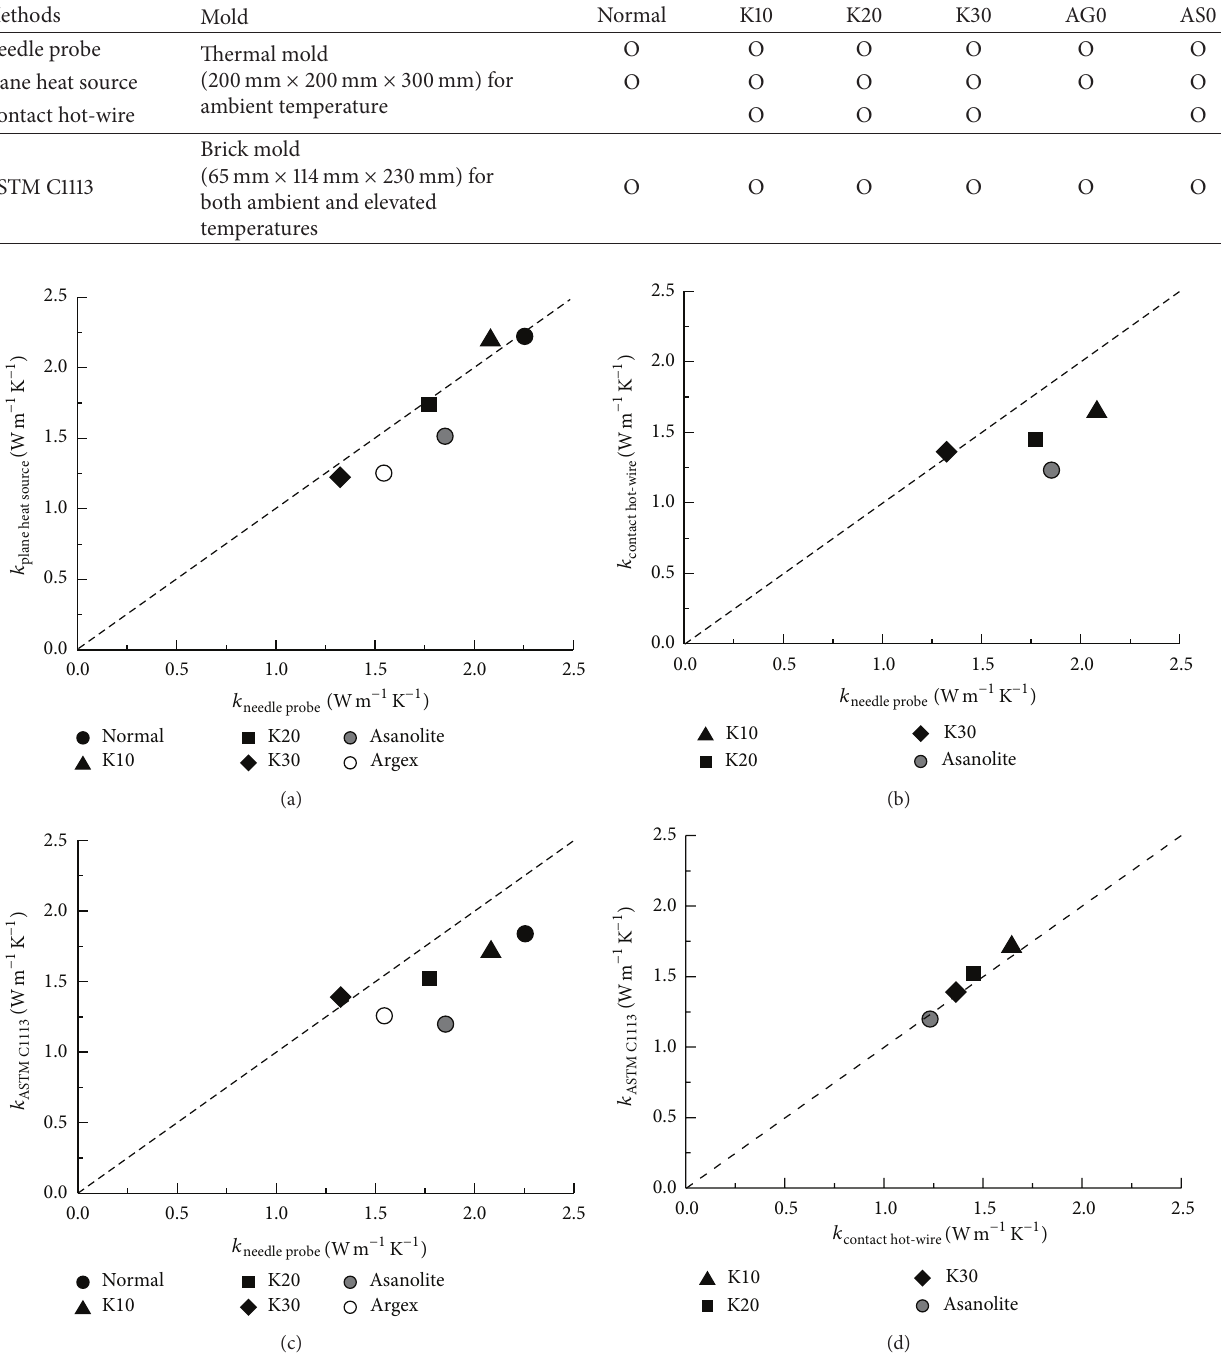
Table 4: Test methods and corresponding specimens.